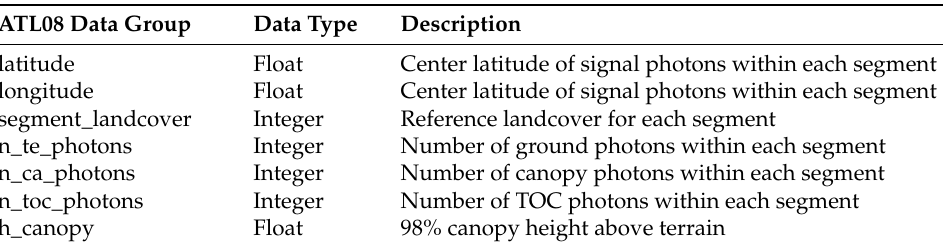
Table 1. Selected sub-data for data simplification [44].